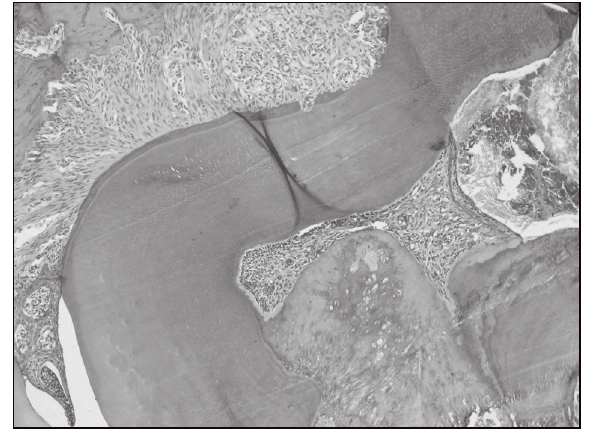
Figure 3 - Photomicrograph of a rat tooth 24 hour after pulpotomy and pulp capping with green propolis extract and iodoform showing mild inflammatory infiltrate (HE, 100 ×